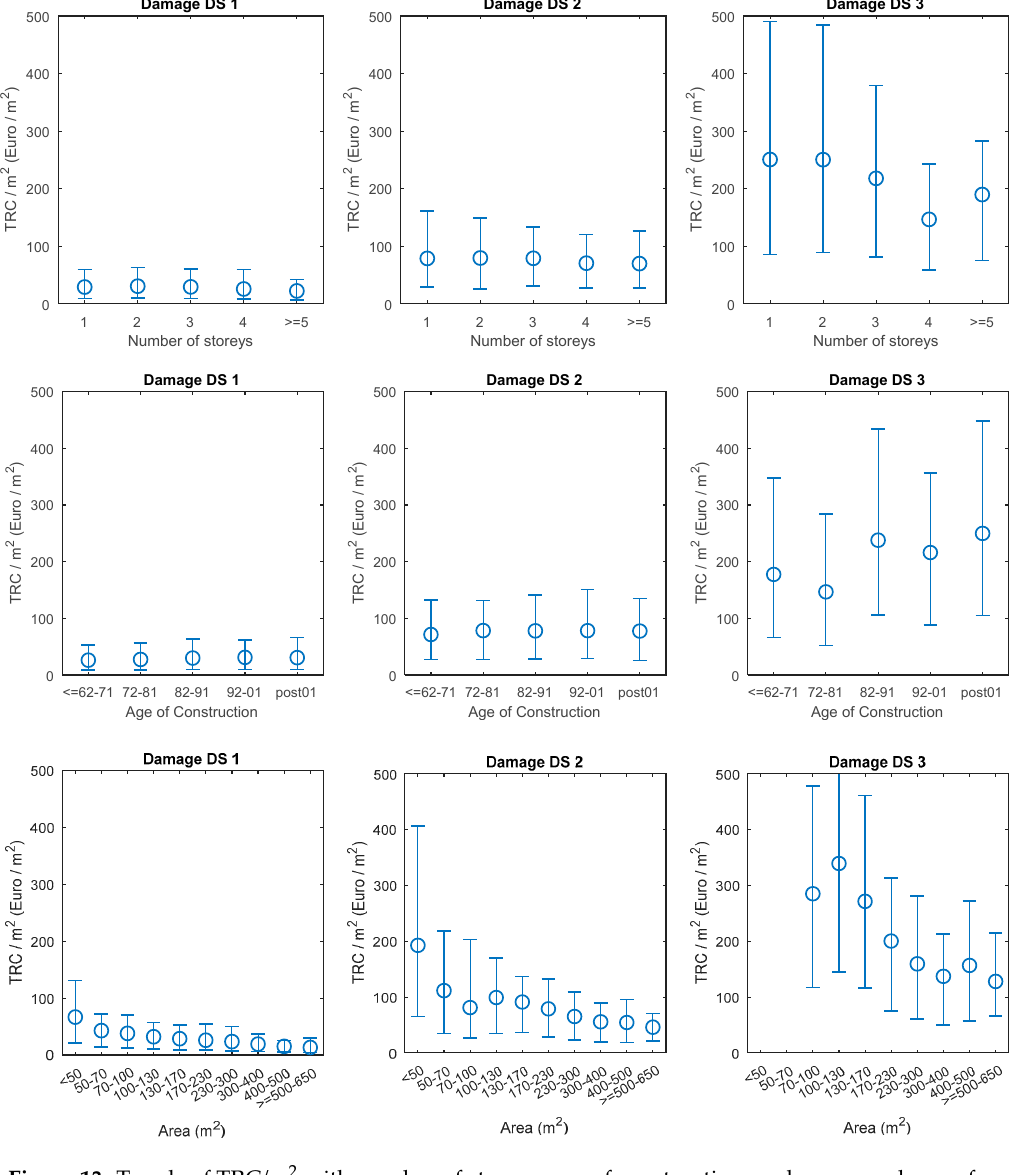
Figure 13. Trends of TRC / m 2 with number of storeys, age of construction, and average plan surface depending on the maximum achieved DS (the figure shows 50th, 16th and 84th percentiles).